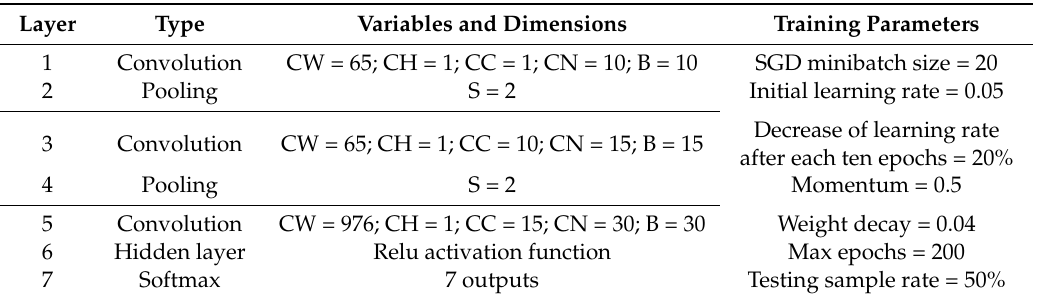
Table 2. Variables of parameters and structures of the deep convolutional neural networks. Layer Variables and Dimensions